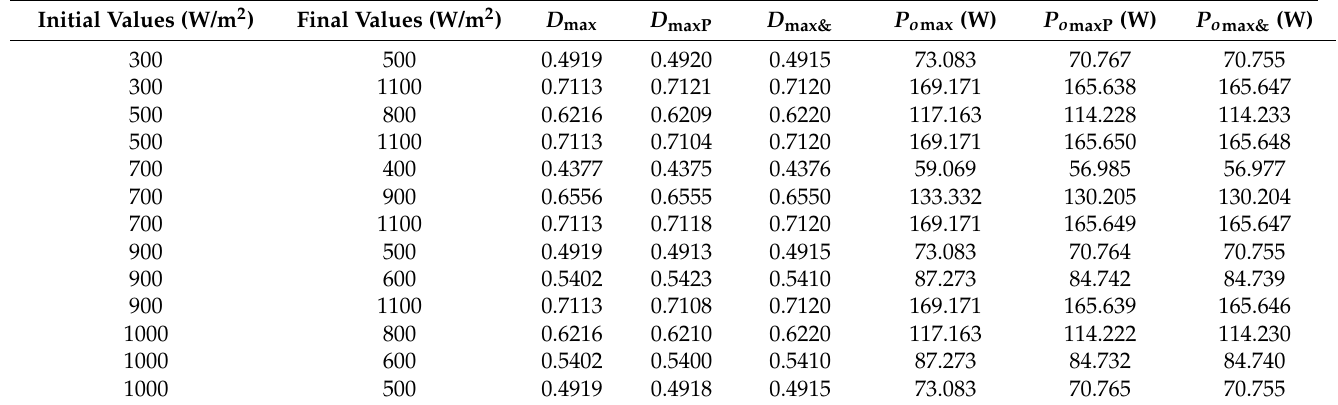
Table 8. Simulation results under arbitrary irradiance conditions.